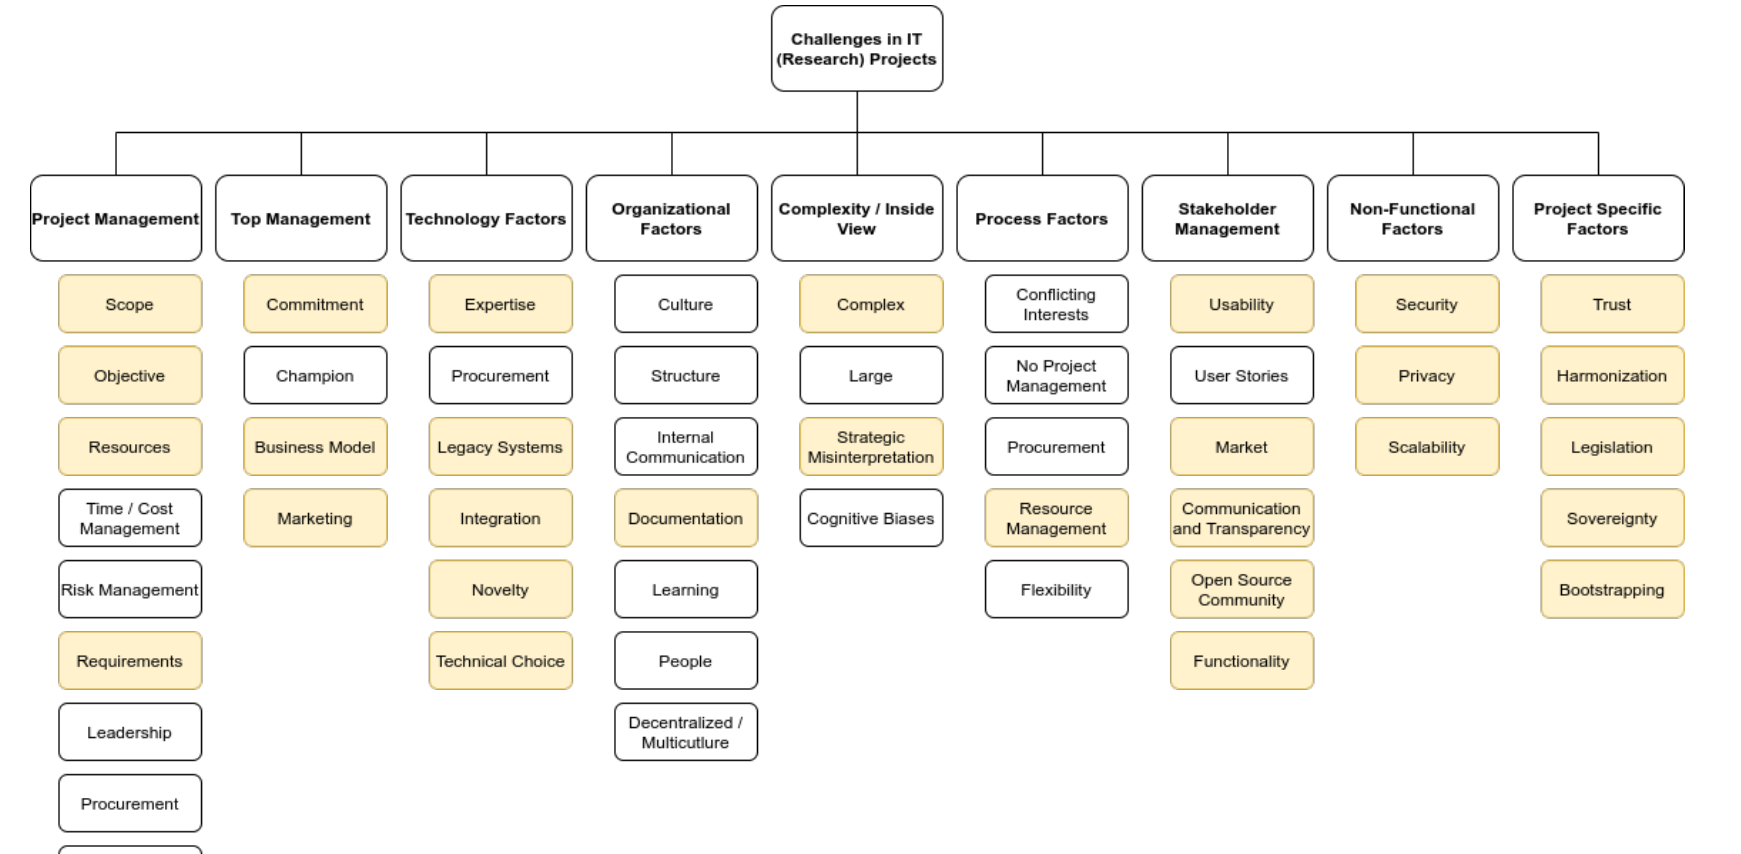
Figure 2. Taxonomy of challenges in eID and SSI